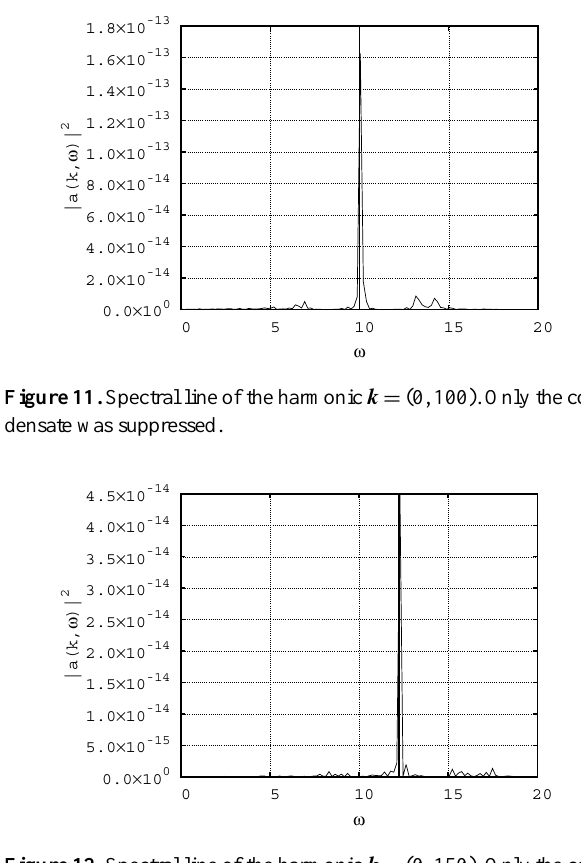
Figure 10. Spectral line of the harmonic k = (0, 50). Only the con- densate was suppressed.